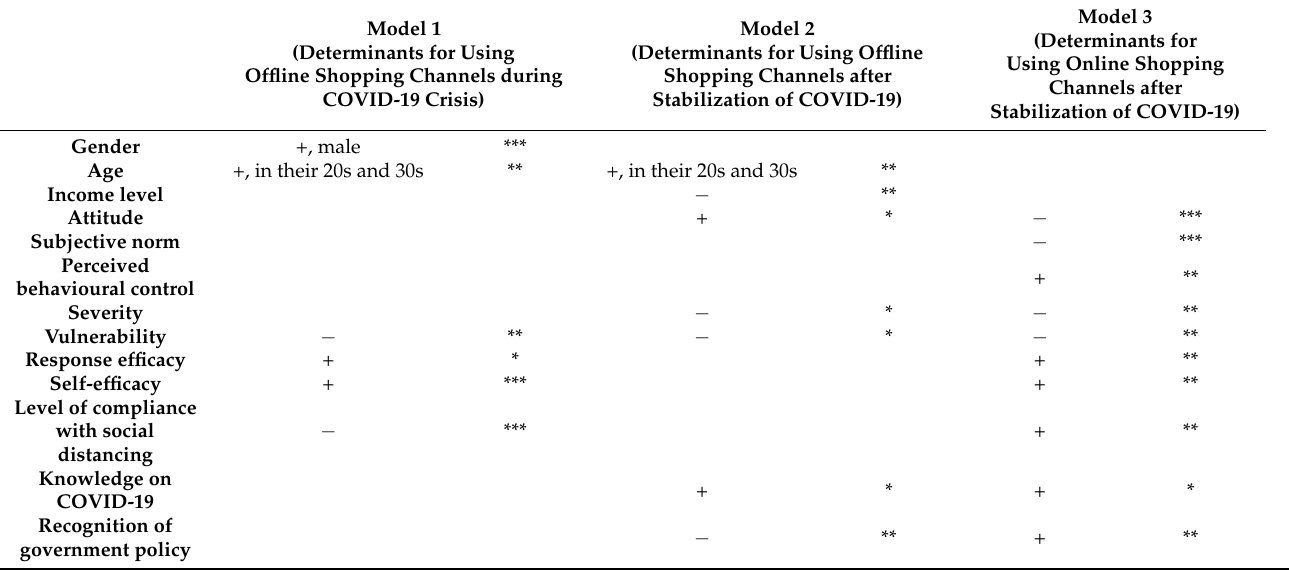
Table 3. Summary of analysis of ordered logit